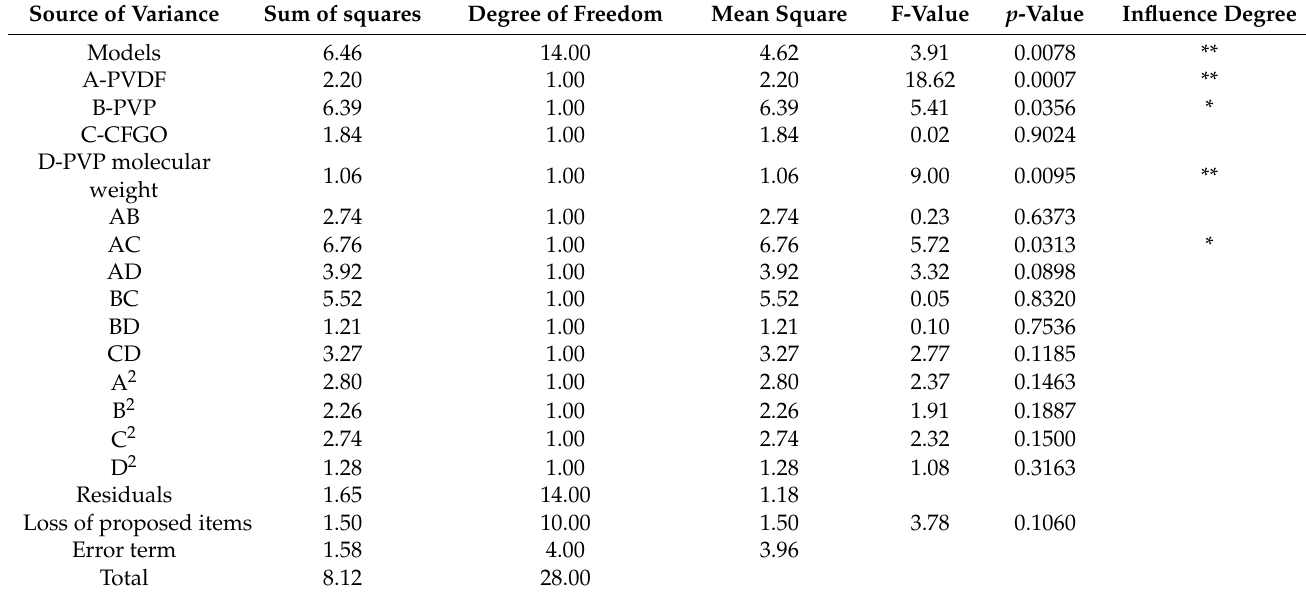
Table 4. Analysis of variance of pure water flux response surface test